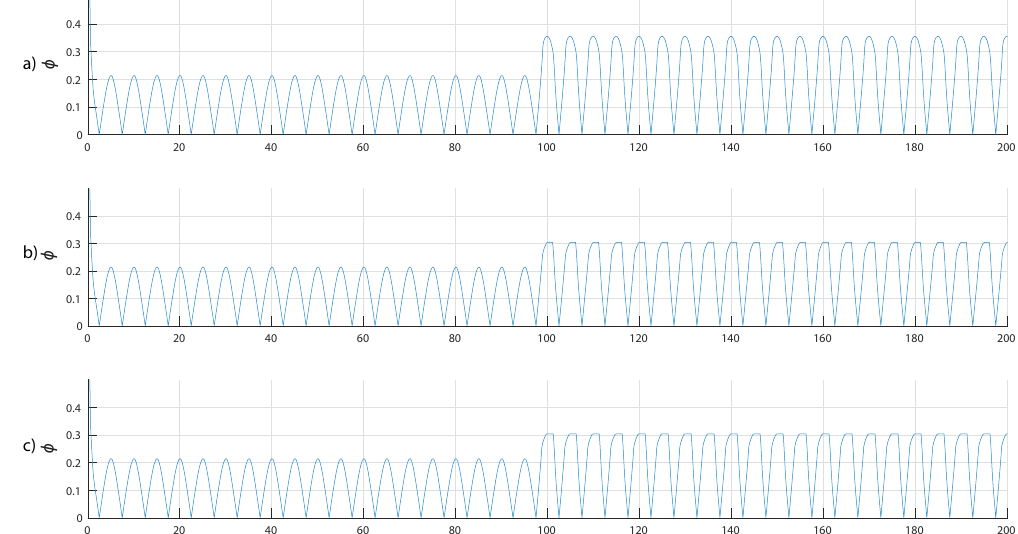
Figure 22. Flow coefficient for the OWC. ( a ) Uncontrolled case. ( b ) ANN1-rotational speed control. ( c ) ANN2-rotational speed